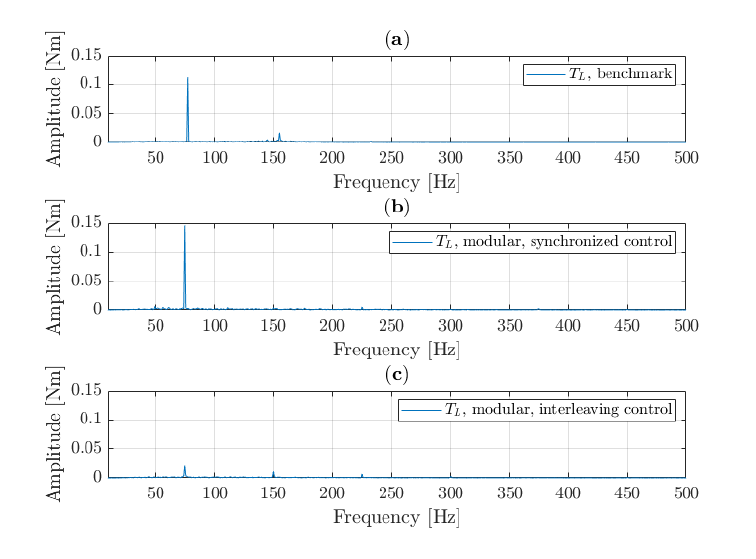
Figure 14. Simulated torque ripple amplitude at 10 kHz PWM switching frequency in ( a ) the benchmark scenario, 0.11 Nm at the resonance mode; ( b ) the synchronized control modular scenario, 0.15 Nm; ( c ) the interleaving control modular scenario, 0.02